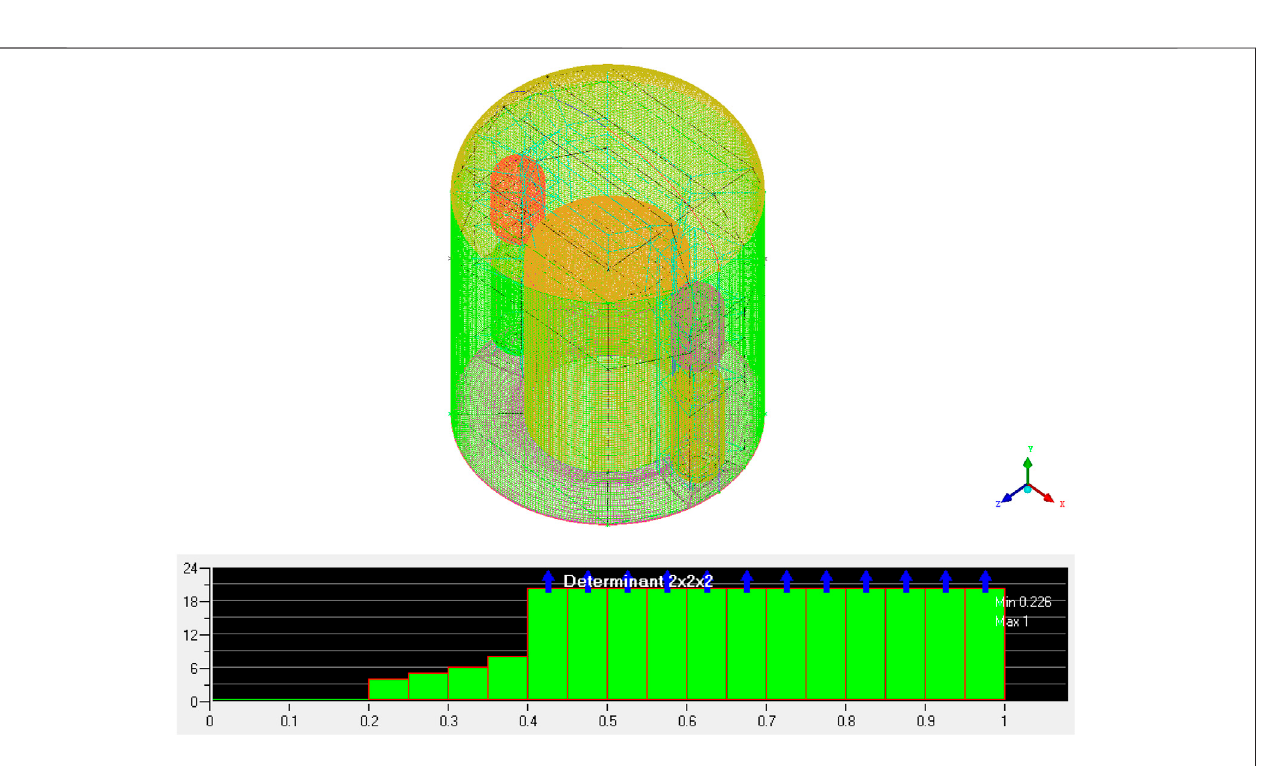
FIGURE 8 | Meshing model and quality.